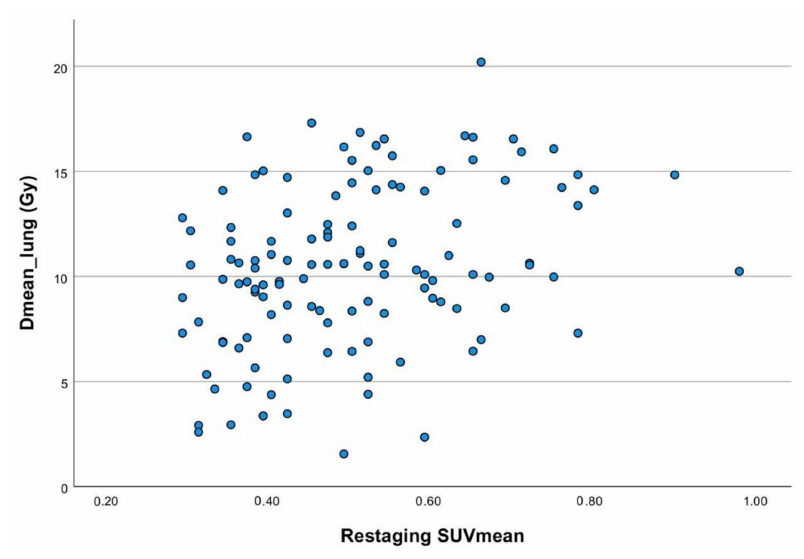
Figure 3. Scatter plot of applied D mean_lung and corresponding SUV mean values in restaging 18F-